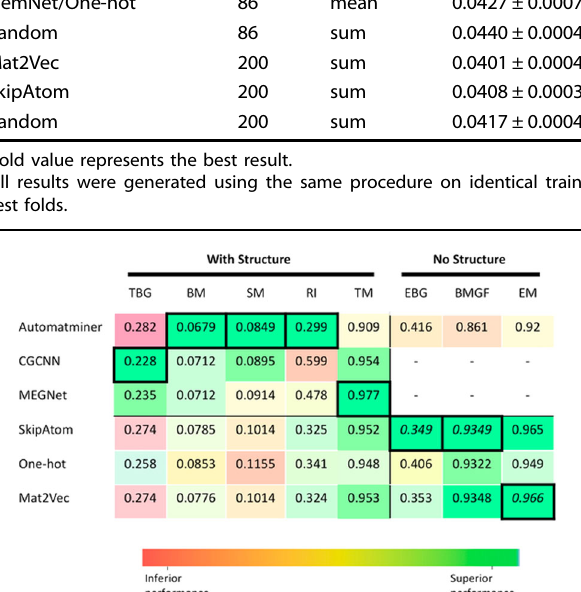
Fig. 5 Performance scores on benchmark tasks. A comparison between the results of the methods described in the current work and existing state-of-the-art results on benchmark tasks. TBG refers to the Theoretical Band Gap task (MAE in eV), BM to the Bulk Modulus task (MAE in log(GPa)), SM to the Shear Modulus task (MAE in log(GPa)), RI to the Refractive Index task (MAE in n ), and TM to the Theoretical Metallicity task (ROC-AUC). These tasks make use of structure information. EBG refers to the Experimental Band Gap task (MAE in eV), BMGF to the Bulk Metallic Glass Formation task (ROC- AUC), EM to the Experimental Metallicity task (ROC-AUC). These tasks make use of composition only. The results that are outlined in bold represent the best score for that task. Italicized results represent an improvement over existing best scores. As described in the “ Methods ” section of this report, the same methodology was used to obtain the results for all of the algorithms in the